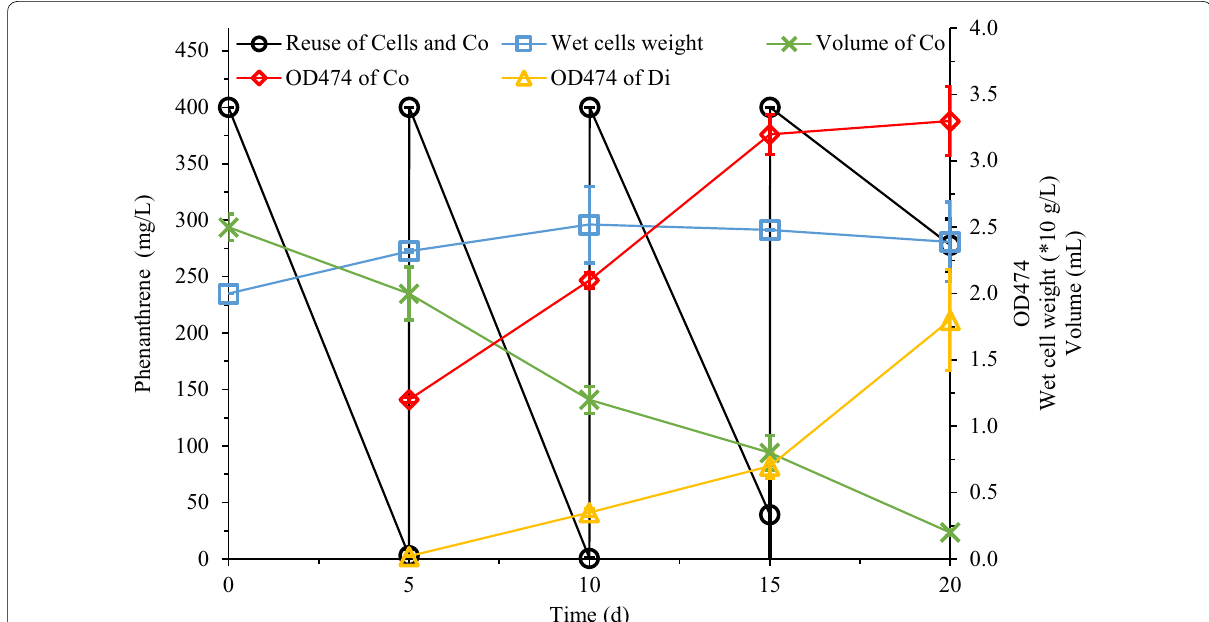
Fig. 4 Reuse of cells plus coacervate phase for phenanthrene biodegradation. S. polyaromaticivorans was inoculated into 30 mL LB medium in a 150-mL flask and cultured at 30 °C and 160 rpm for 18 h. Cells were collected and then inoculated in CPS to degrade phenanthrene for 5 days. Subsequently, the dilute phase of CPS was discarded and 400 mg/L of phenanthrene was added every 5 days. Co: coacervate phases; Di: dilute